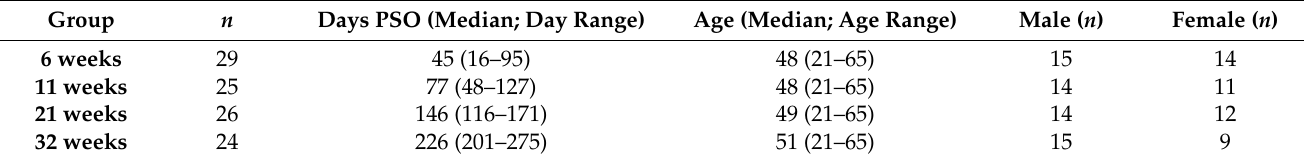
Table 1. Longitudinal COVID-19 convalescent